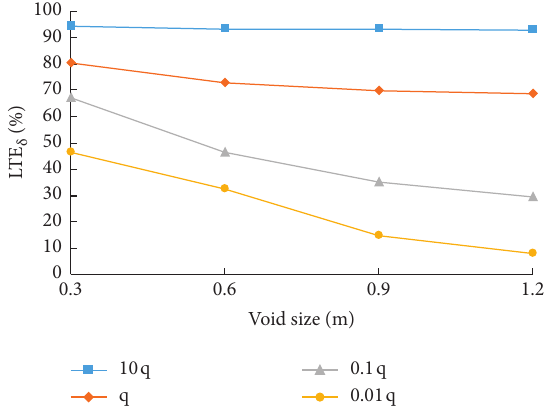
Figure 14: Relationship between void size and LTE